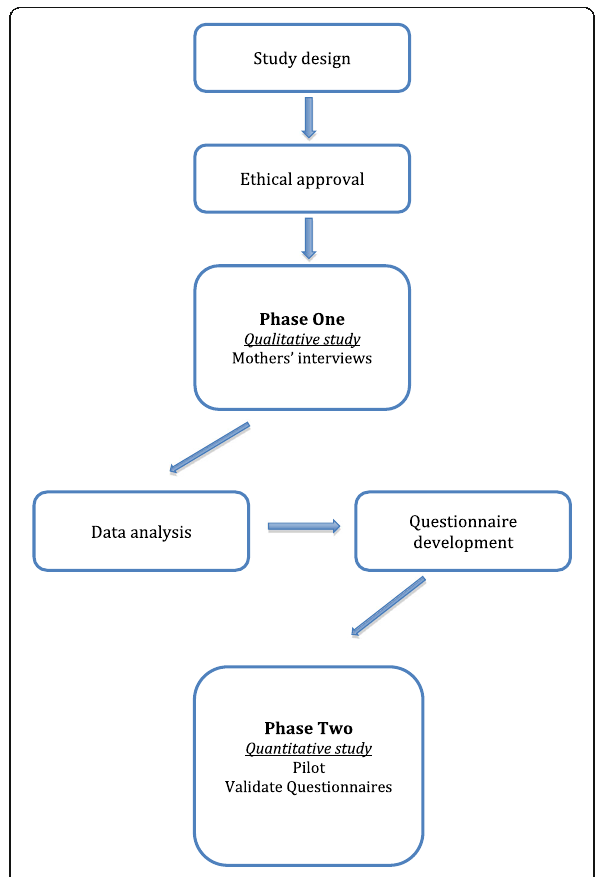
Fig. 1 Flowchart of the study